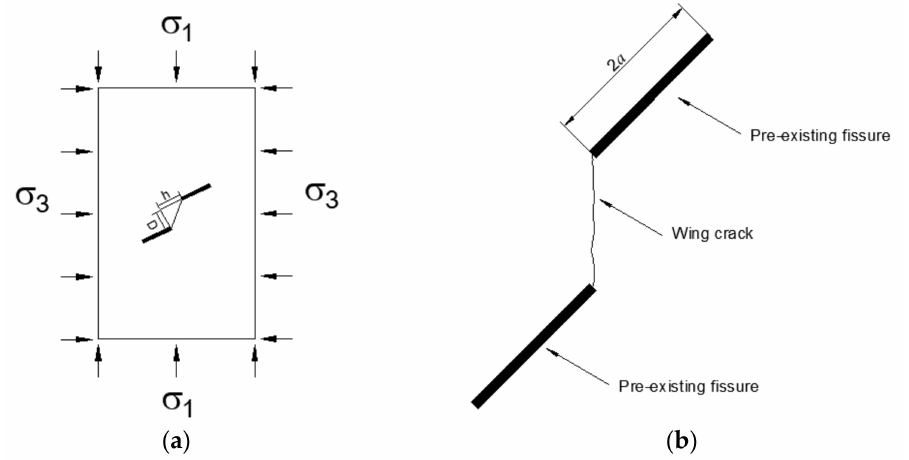
Figure 12. Characteristics of crag bridge shear failure (wing crack—wing crack failure mode). ( a ) Diagram of crack force; ( b ) failure characteristics of crag